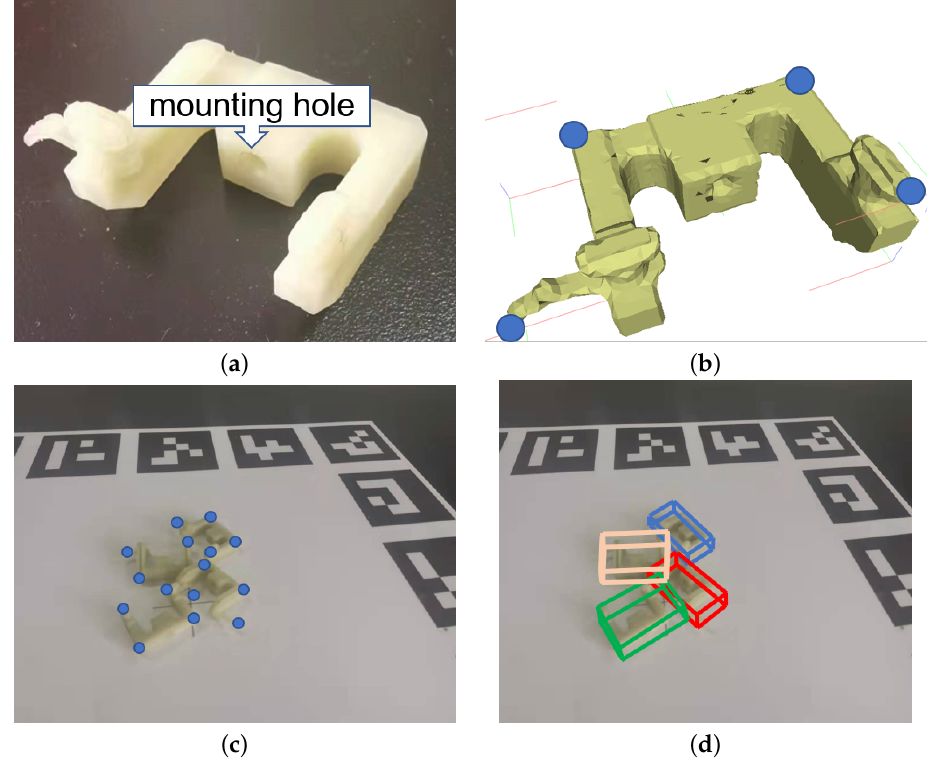
Figure 3. Preparation for the training and testing dataset of the antenna support. ( a ) The appearance of the antenna support. ( b ) Selected key points from 3D mesh model of the antenna support. ( c ) Correspondences in the 2D image. ( d ) Final ground-truth poses of the antenna supports calculated through